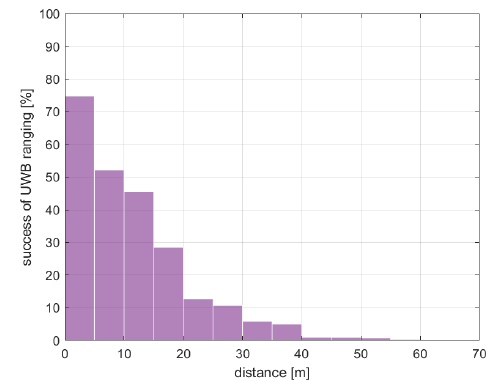
Figure 5. V2V Pozyx range success rate varying the distance between the transceivers (left network).